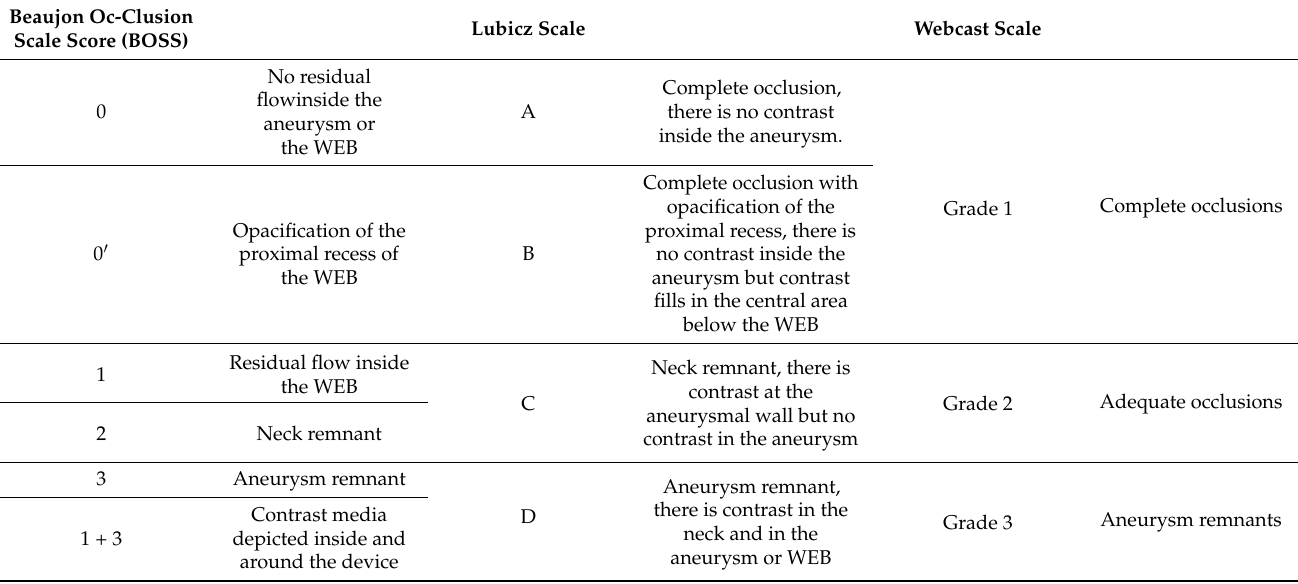
Table 1. Describes the different scales used in the study: the Beaujon Occlusion Scale Score (BOSS), the Lubicz Scale, and the scale used in the WebCast study (WEBCAST Scale).